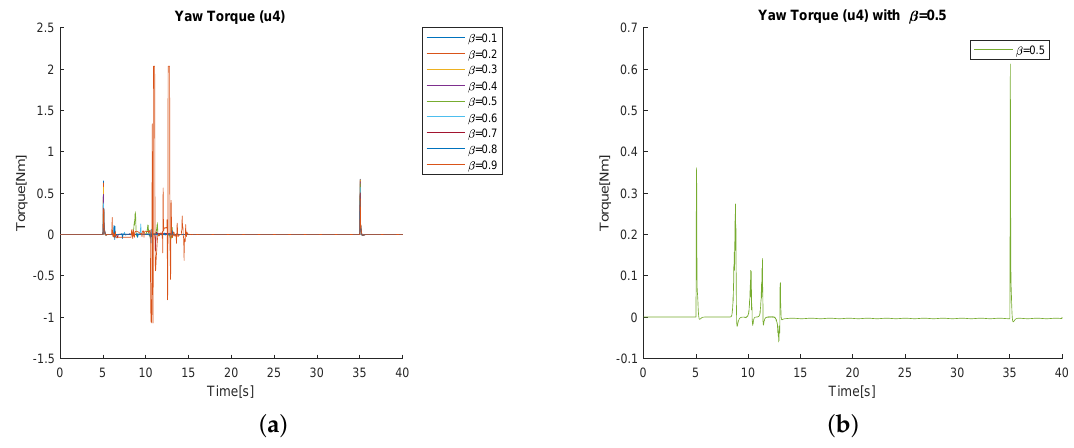
Figure 15. ( a ) Yaw Torque with distinct β ’s; ( b ) Yaw Torque with β = 0.5.